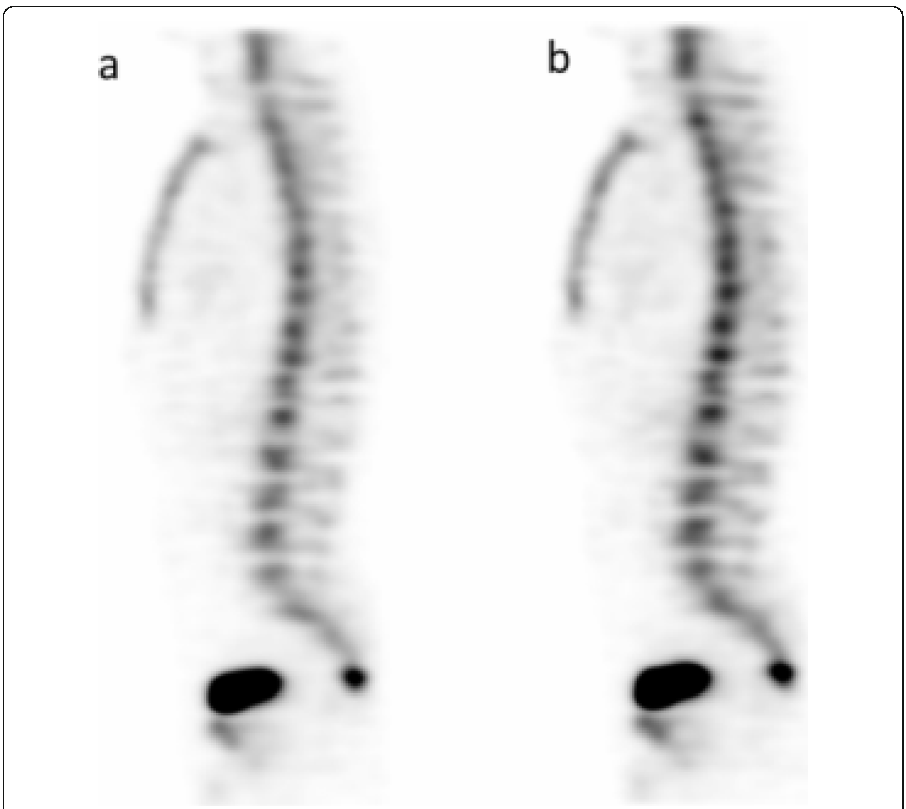
Fig. 2 Bone SPECT. Comparison between SS ( a ) and SimSSC ( b ) images on a sagittal view. Images